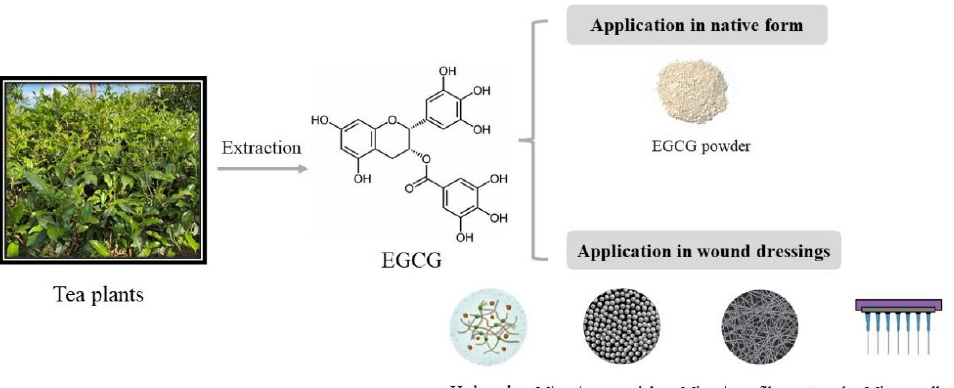
Figure 1. The native and wound dressing forms of